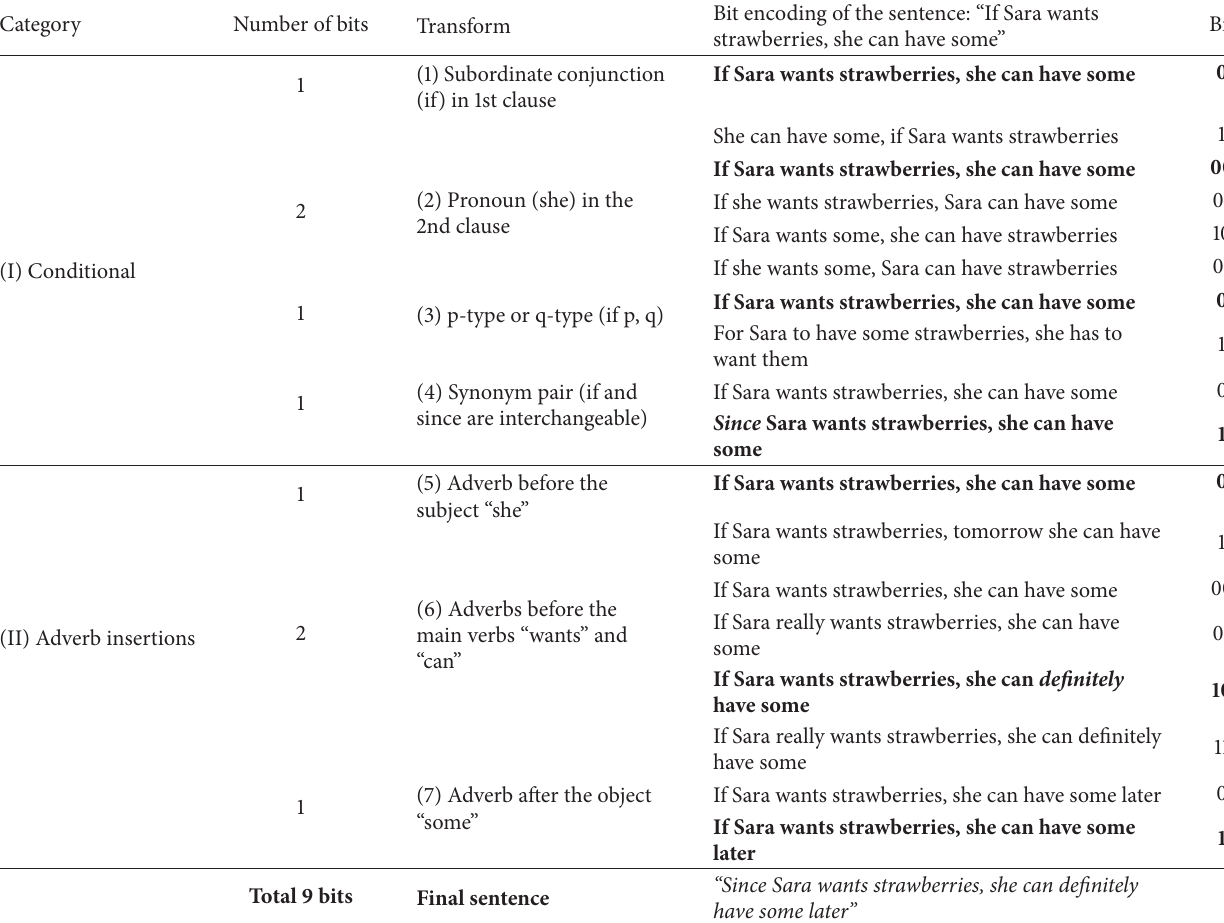
Table 9: Example of the transformation process applied to the sentence “If Sara wants strawberries, she can have some.” The sentence was transformed to “Since Sara wants strawberries, she can definitely have some” which embeds the 9 bits of a secret message: 0 00 0 1 0 10 1. Category